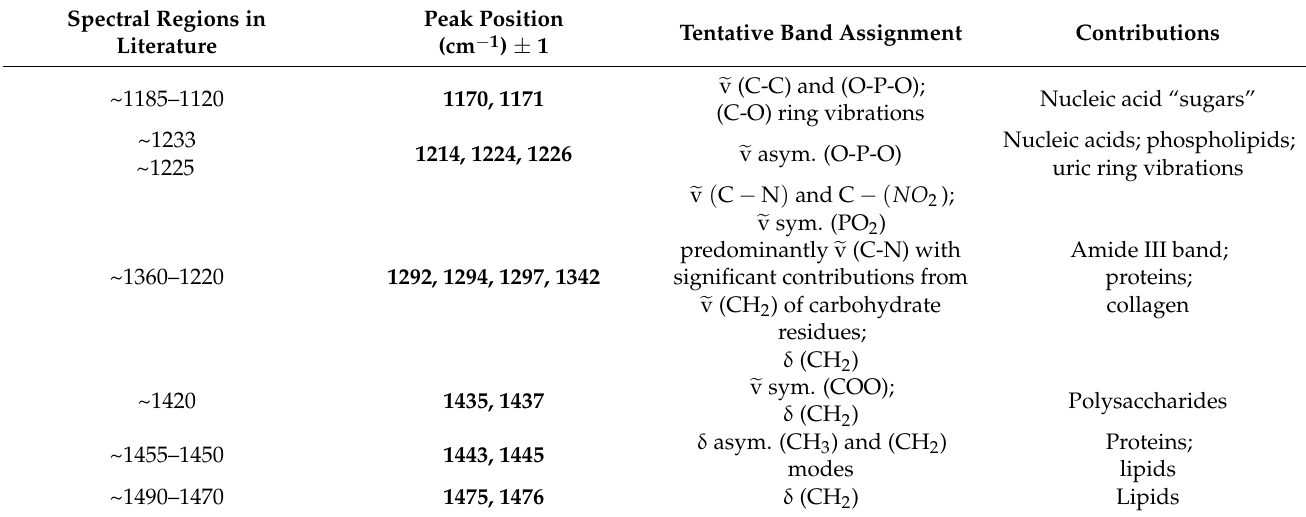
Table A2. Biochemical tentative assignments of the most discriminant wavenumbers selected by SELECT-LDA in the classification approach aimed at stratifying PD patients.